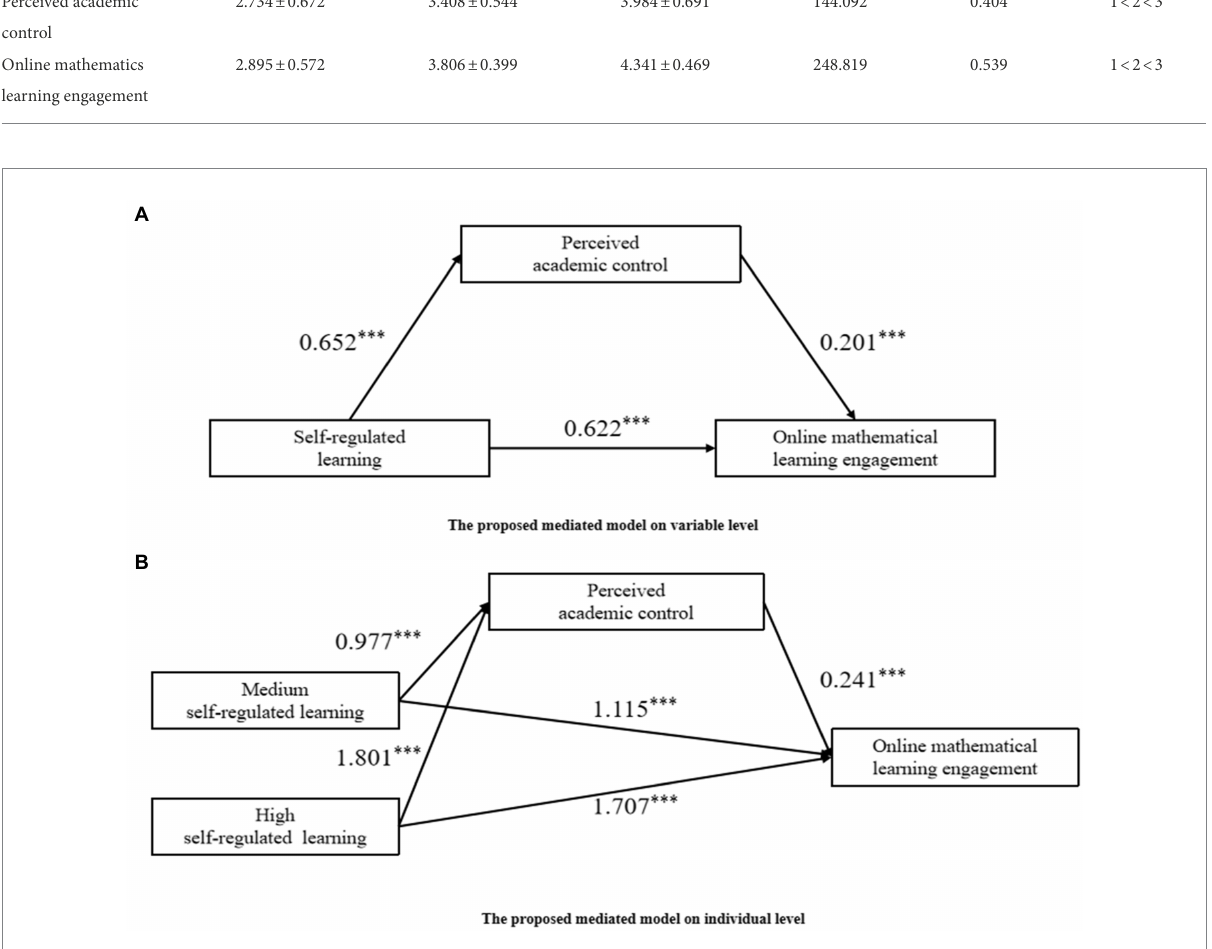
FIGURE 2 (A) The proposed mediated model on variable level. (B) The proposed mediated model on individual level. *** p <